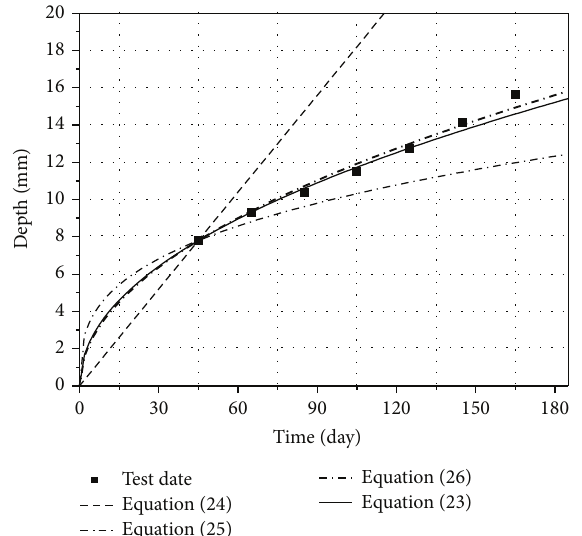
Figure 5: Comparisons of various predictions of diffusion depth with test.